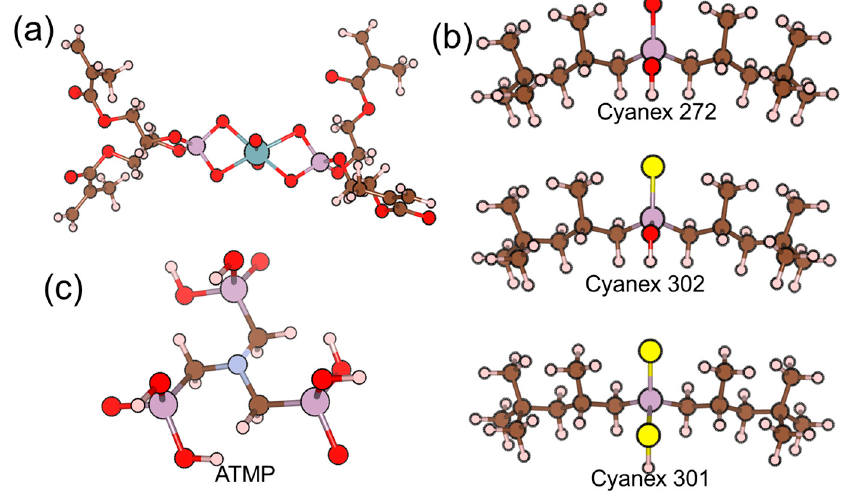
Figure 7. ( a ) Configuration of uranyl coordination by phosphate groups of B2MP; ( b ) Structures of Cyanex 272, Cyanex 302, and Cyanex 301; ( c ) Structures of amino(trimethyl) phosphate.